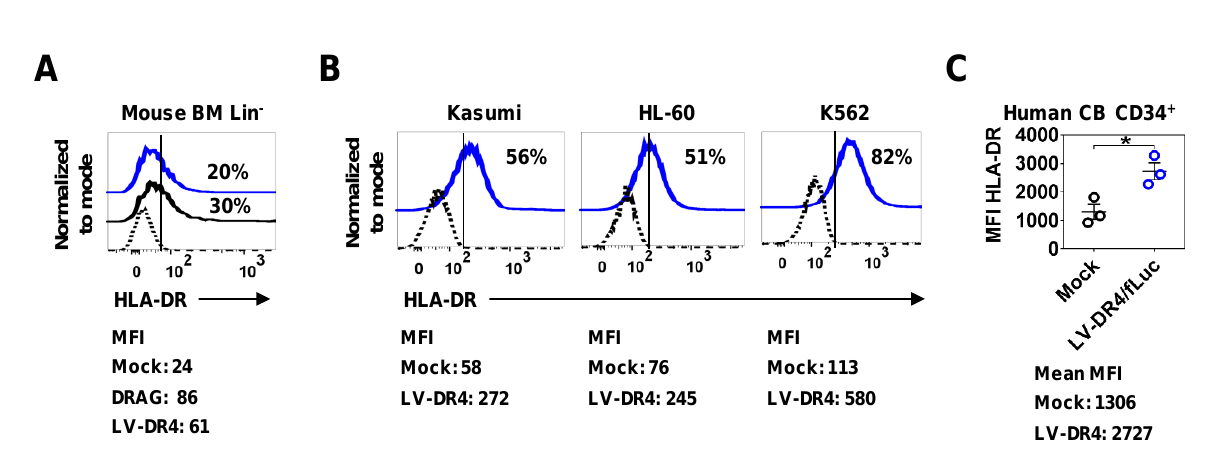
Figure 3. Surface expression of DR4 dimer on hematopoietic cells analyzed by flow cytometry. ( A ) LV-DR4/fLuc transduction of Lin − mouse bone marrow cells obtained from NRG mice and detection of HLA-DR dimer on the cell surface. Lin − mouse bone marrow cells obtained from DRAG mice were used as a positive control for HLA-DR expression analyses (black line). Mock (dashed black line) and LV-DR4/fLuc transduced (blue line). Representative results from duplicate experiments; ( B ) Human Kasumi, HL-60, and K562 leukemia cell lines showing expression of HLA-DR dimer on the cell surface after LV-DR4/fLuc transduction. Mock (dashed black line) and LV-DR4/fLuc transduced (blue line). Representative results from duplicate experiments; ( C ) LV-DR4/fLuc transduction of CB CD34 + cells and upregulation of HLA-DR expression (n = 3). Mock (black dots) and LV-DR4/fLuc transduced (blue dots). * p < 0.05 ( t -test, unpaired). The mean fluorescence intensity (MFI) is indicated in each panel.